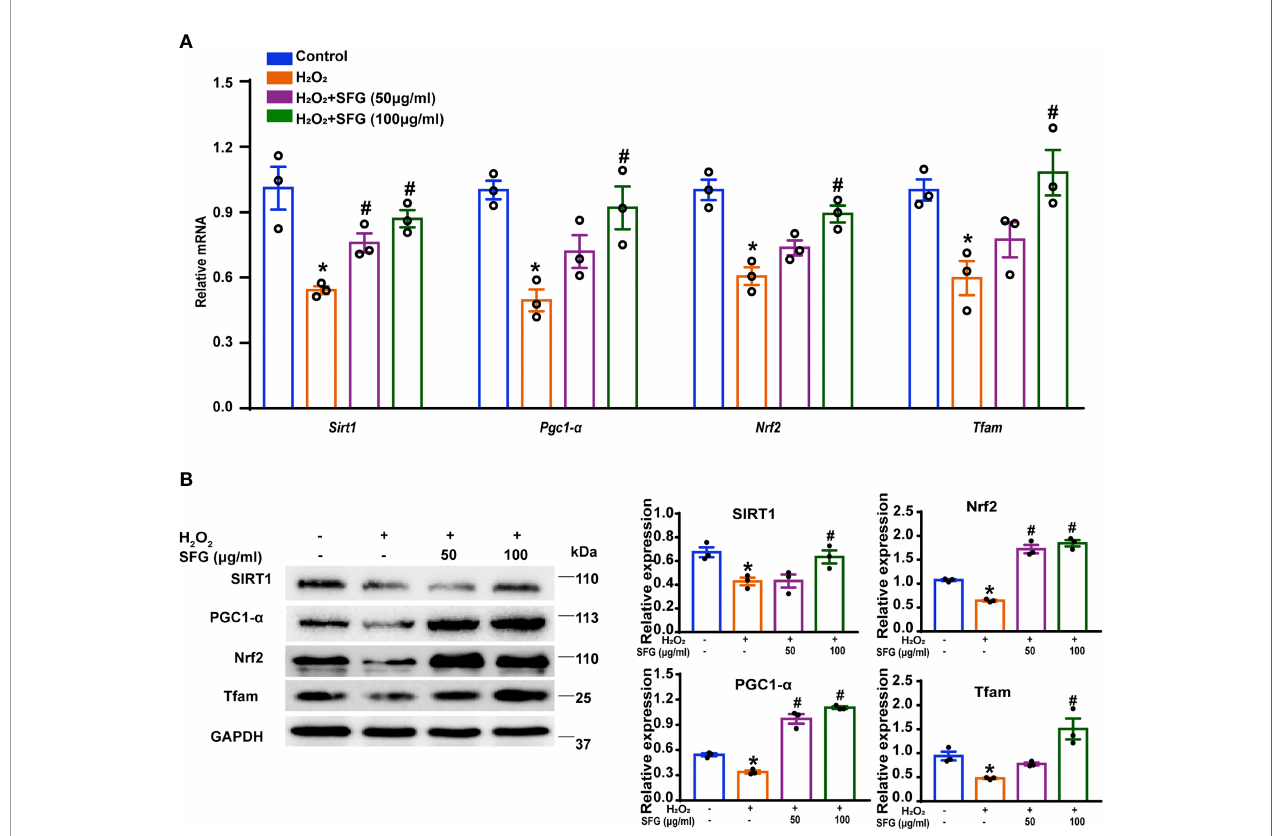
FIGURE 6 | SFG counteracts the H 2 O 2 -induced negative effect on the PGC1- a signaling pathway in MIN6 cells. (A) Sirt1 , Pgc1a , Tfam , and Nrf2 gene expression (n=3). *P < 0.05 versus control; # P < 0.05 versus H 2 O 2 -only group. (B) Western blot of SIRT1, PGC1- a , Tfam, and Nrf2 (n=3). GAPDH was used as a loading control. Densitometric analysis of the Western blot bands were shown. *P < 0.05 versus control; # P < 0.05 versus H 2 O 2 -only